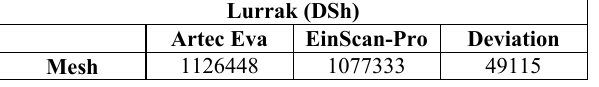
Table 4. DSh analysis of the “Ilarik II” model